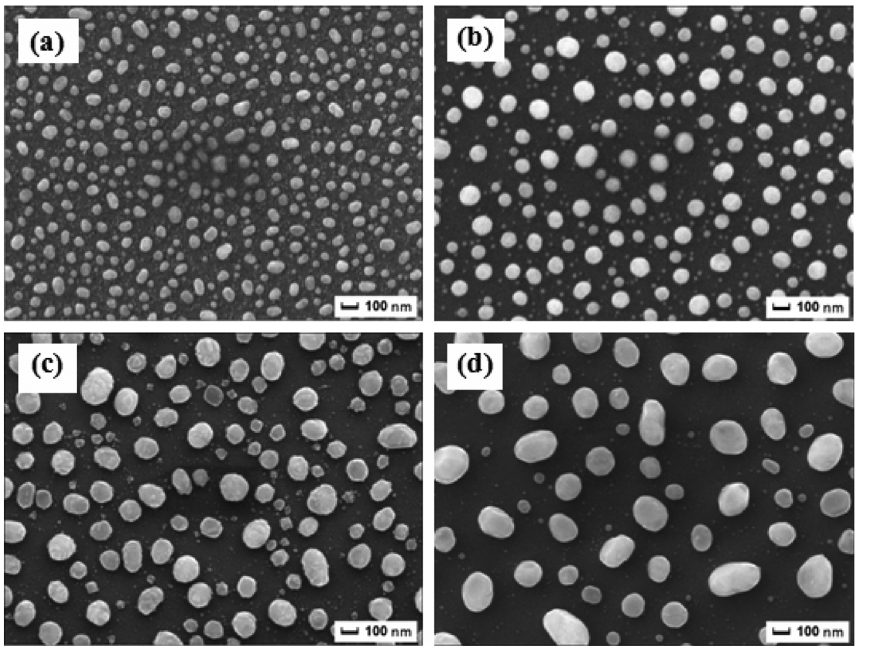
Figure 2: SEM images of nickel